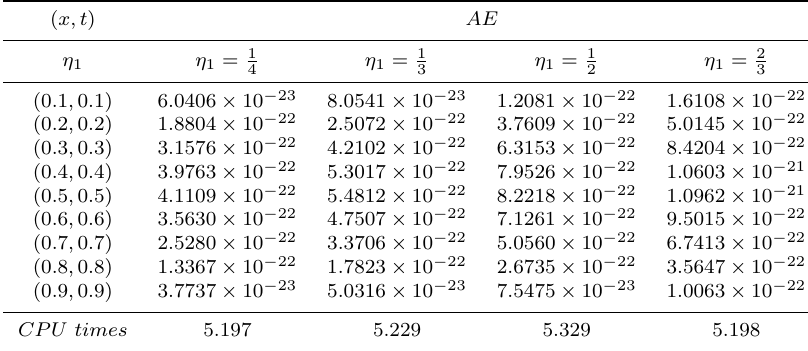
Table 3. The comparison of the absolute error(AE) obtained by our numerical method at some selected points with m = m ′ = 1, M = M ′ = 64, η = 1 and different values of η 1 for Example 2.